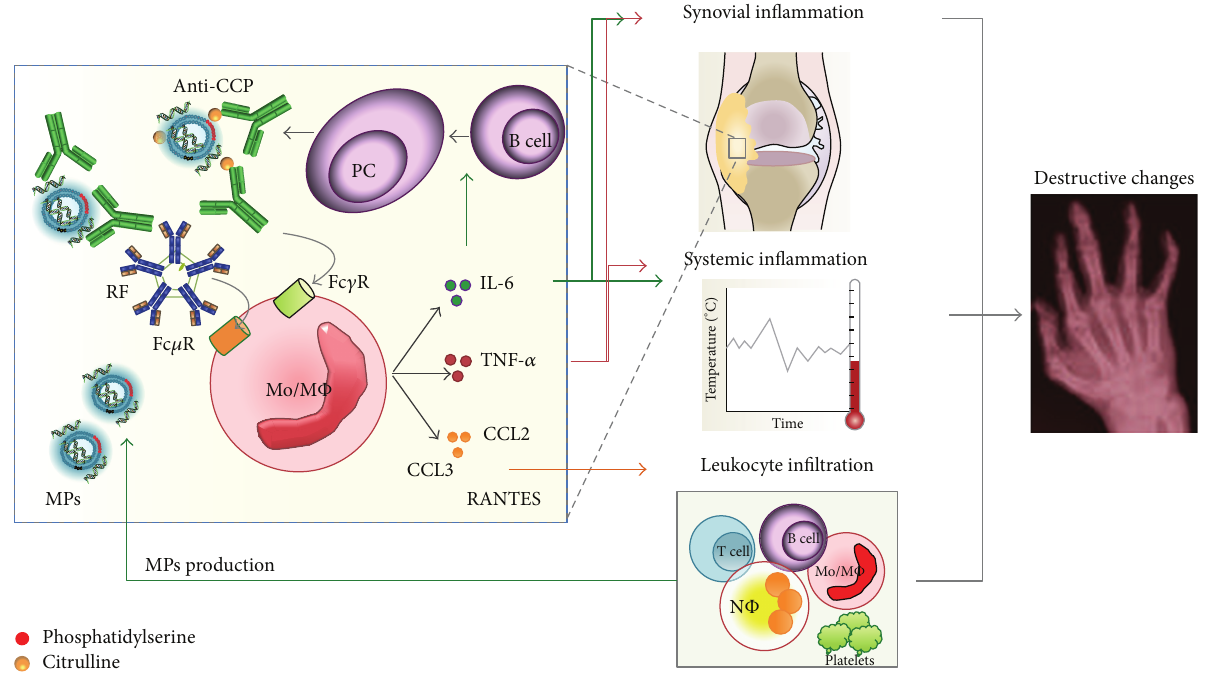
Figure 4: Role of MPs in RA. The high concentrations of MPs from different leukocyte populations reported in the synovial fluid from RA patients must be citrullinated and form ICs with anti-CCP antibodies and RF autoantibodies. These complex structures could be recognized by Mo/M Φ through isotype-specific Fc receptors (Fc 𝛾 R and Fc 𝜇 R) and induce the production of proinflammatory cytokines such as TNF- alpha, IL-6, and the chemokines CCL2, CCL3, and RANTES. These soluble factors participate in the systemic inflammation in the synovium and the destructive changes observed in the joints of RA patients. IL-6 is also involved in the induction of plasma cells (PCs) producing